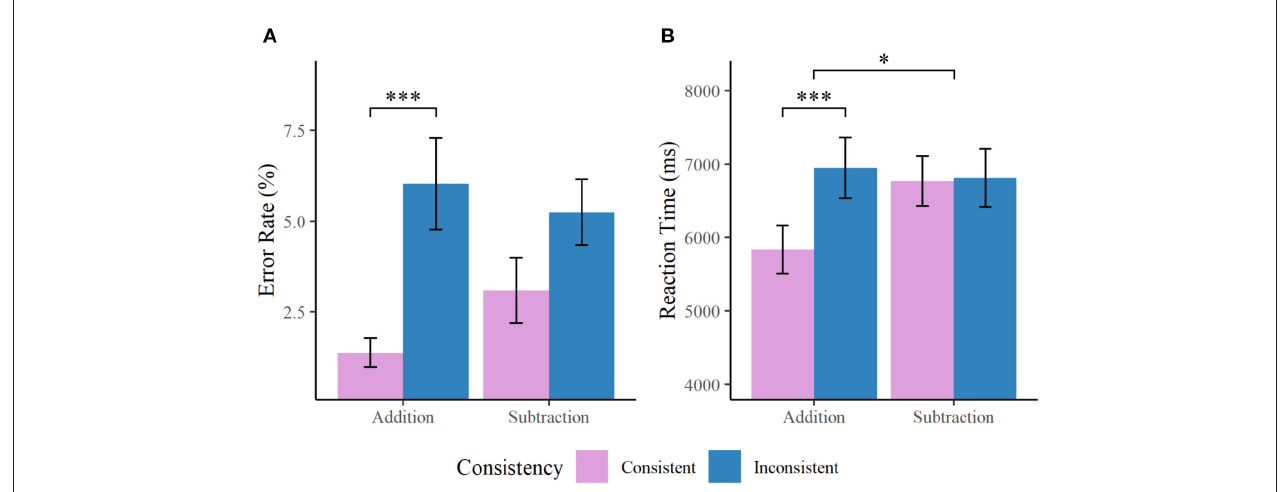
FIGURE 2 | Bar charts showing (A) error rate and (B) reaction time of the out-of-scanner word problem task. Participants responded more accurately and faster to consistent than inconsistent problems. Interaction between consistency and operation was detected for the reaction time that lexically inconsistent problems were responded more slowly than consistent problems for addition, but such a difference was not observed for subtraction problems. * p < 0.05, *** p < 0.001.